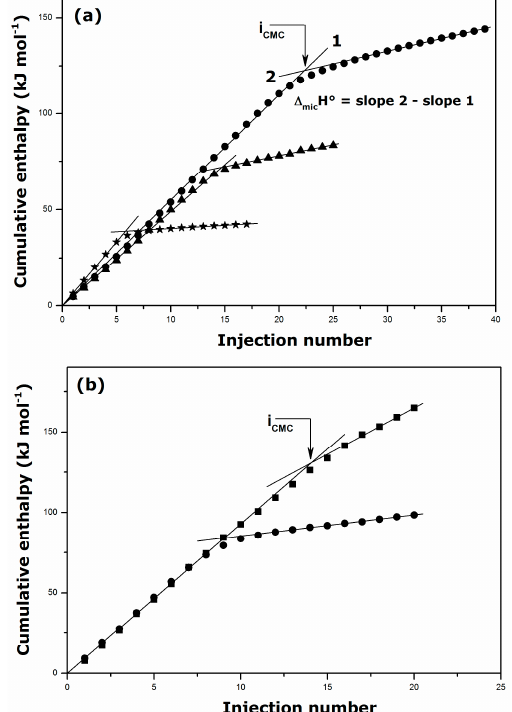
Figure 6. Effect of NaCl addition on the cumulative enthalpy of dilution per mole of DGC ( a ) and DDGC ( b ) determined by Isothermal Titration Calorimetry at 298 K: single-solute solution (circles), 0.001 NaCl solution (triangles), 0.01 NaCl solution (squares), 0.1 NaCl solution (stars). The enthalpy of dilution has been plotted as a function of the injection number to illustrate the direct calculation of the enthalpy of surfactant